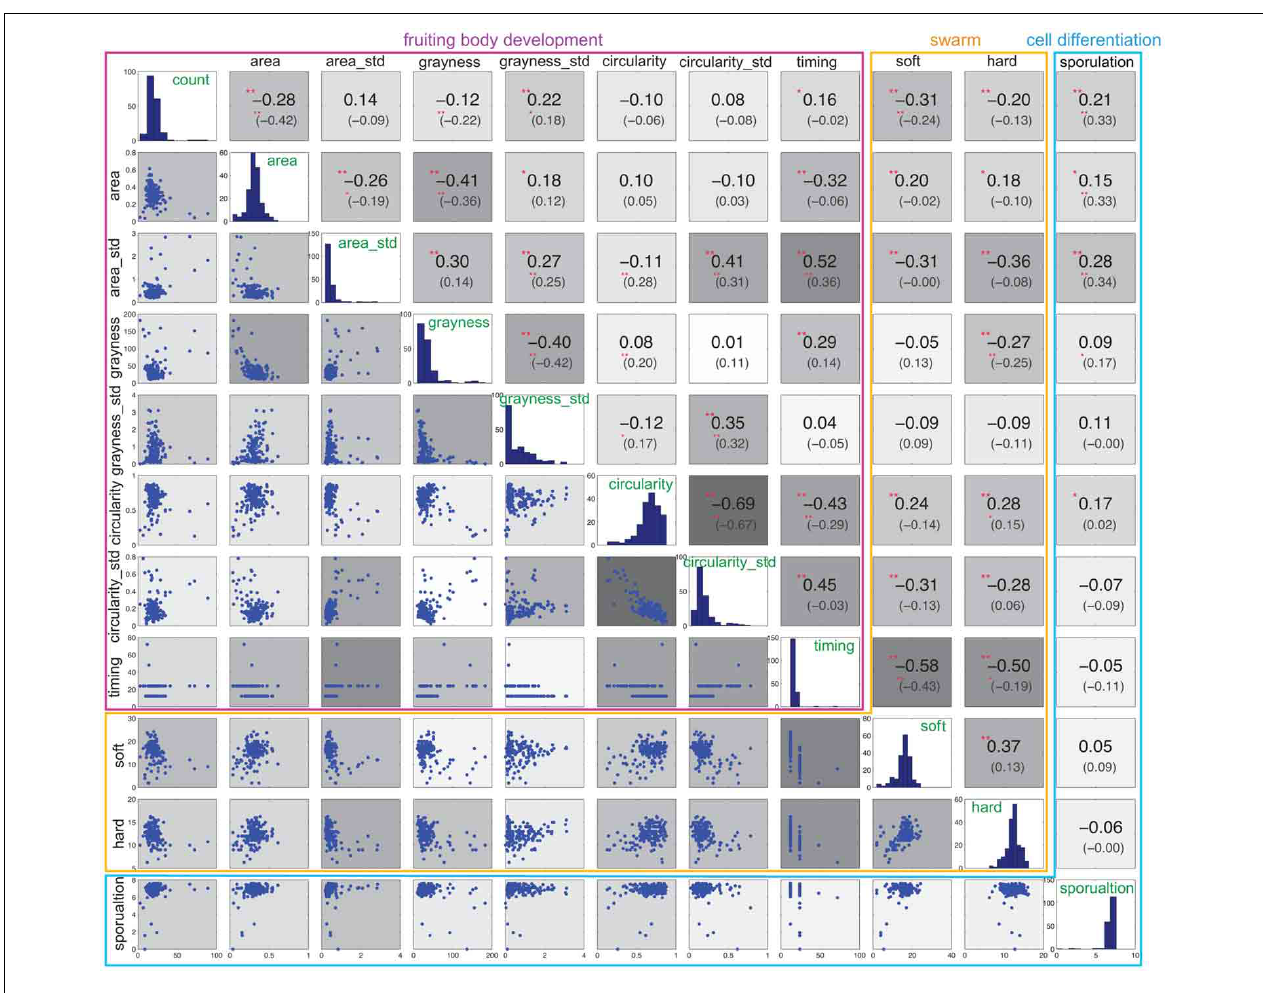
FIGURE 4 | Correlation of phenotypic variables. The histogram in the diagonal panels shows the distribution of each phenotypic trait. The value of Spearman’s rank correlation is the first number shown above the diagonal. The number inside the parenthesis is the Spearman’s rank